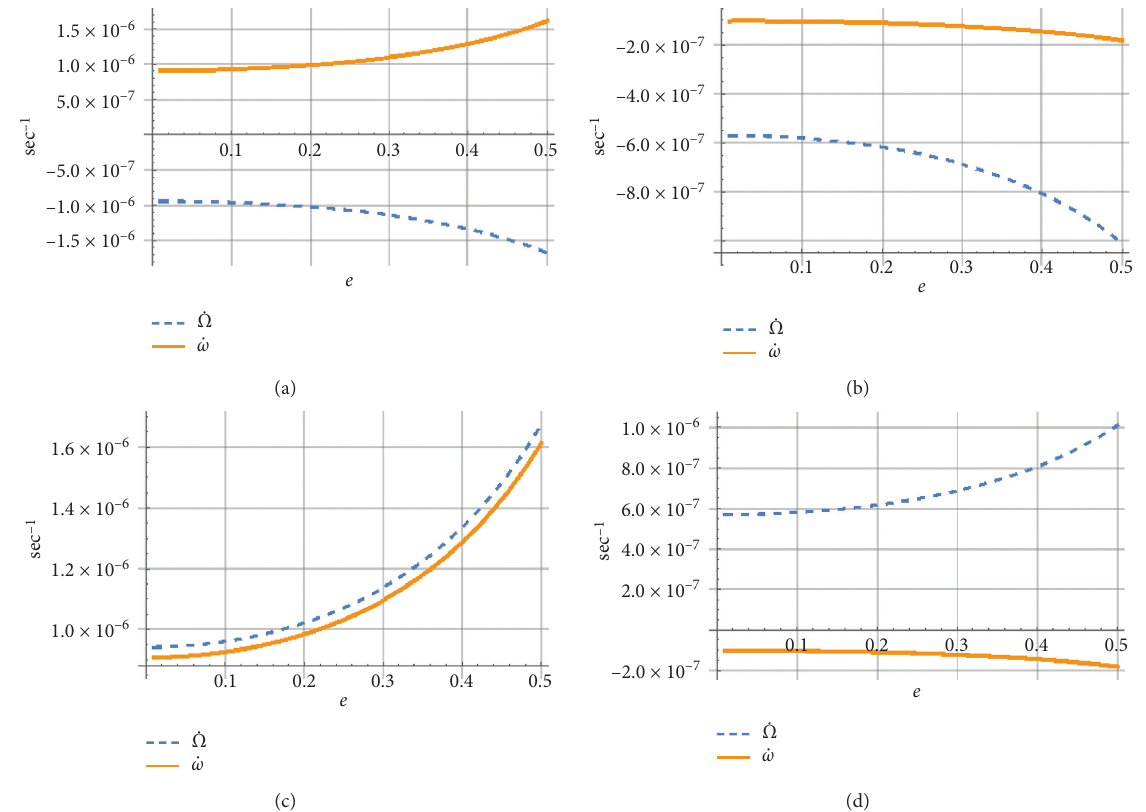
Figure 12: Curves of _ Ω and _ ω with e for the 4 cases corresponding to F ( i ) � 0.2. (a) i � − 47 . 16, (b) i � 65 . 56, (c) i � − 132 . 84,and (d) i � 114 .